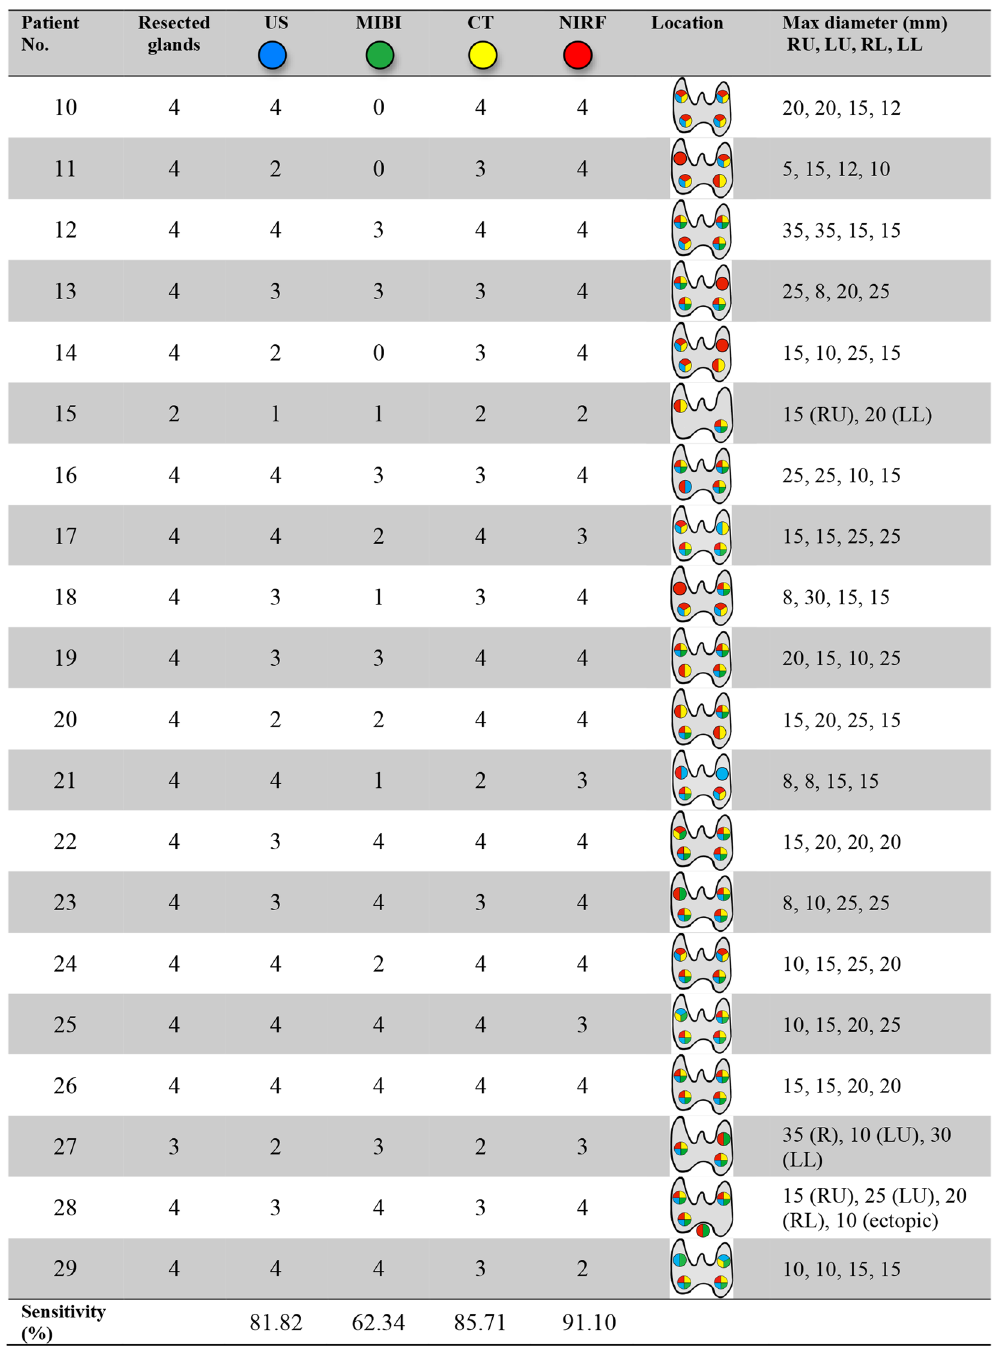
Figure 6. Number and location of the detected glands by different modalities and the max diameter of resected glands. Abbreviations: R, right; L, left; RU, right upper; LU, left upper; RL, right lower; LL, left